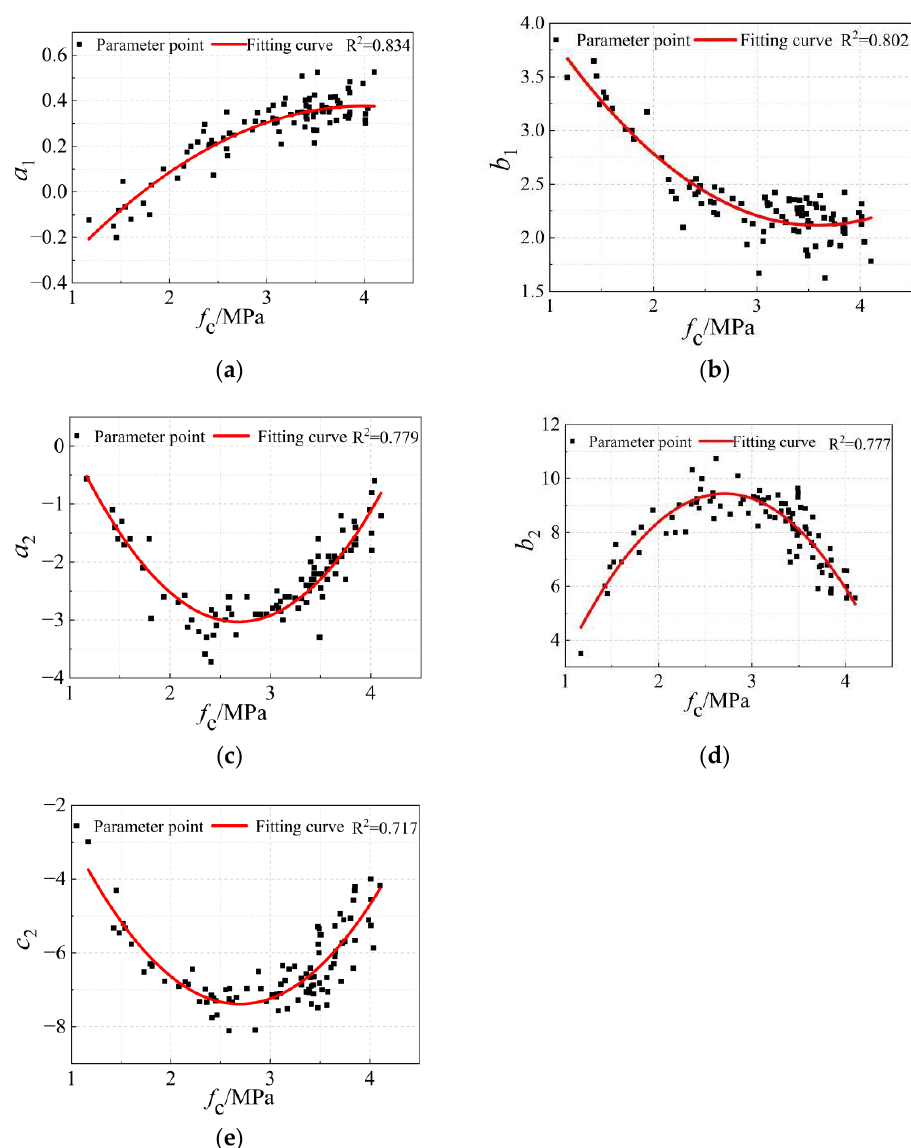
Figure 14. Compressive strength and curve shape parameter fitting curves: ( a ) a 1 ; ( b ) b 1 ; ( c ) a 2 ; ( d ) b 2 ; and ( e ) c 2 .